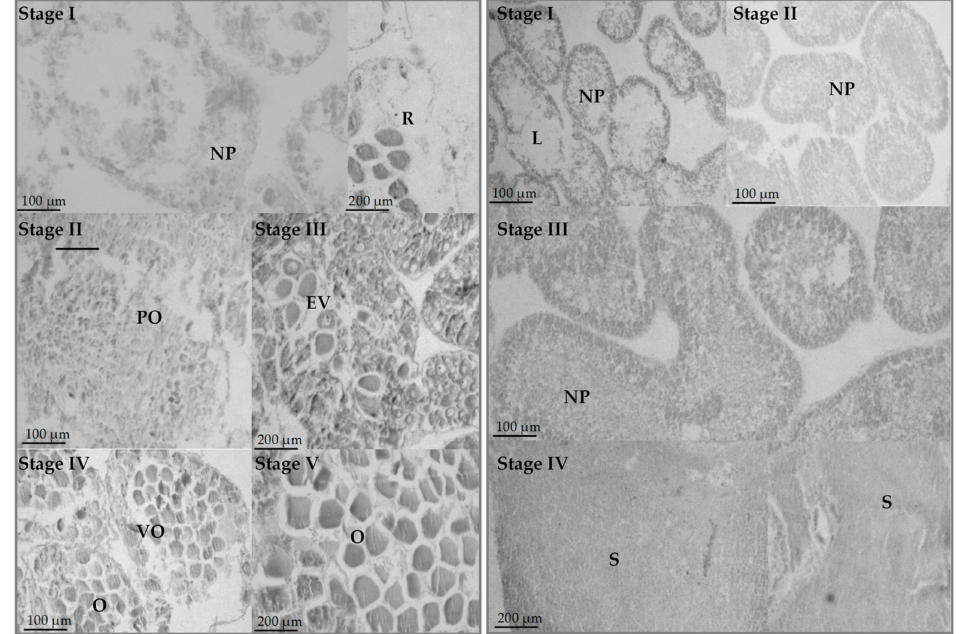
Figure 3. Histology of ovaries ( left ) and testes ( right ) of Paracentrotus lividus . NP = nutritive phagocytes, R = relict oocytes, PO = previtellogenic oocytes, EV = early vitellogenic oocytes, VO = vitellogenic oocytes, O = oocytes, L = lumen, and S =